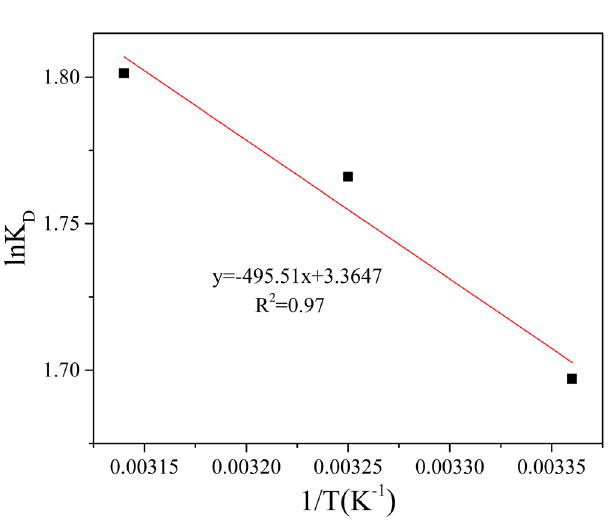
Figure 17. Linear fit for the Thermodynamic parameters for Mn(II) sorption onto GAD hydrogel beads.